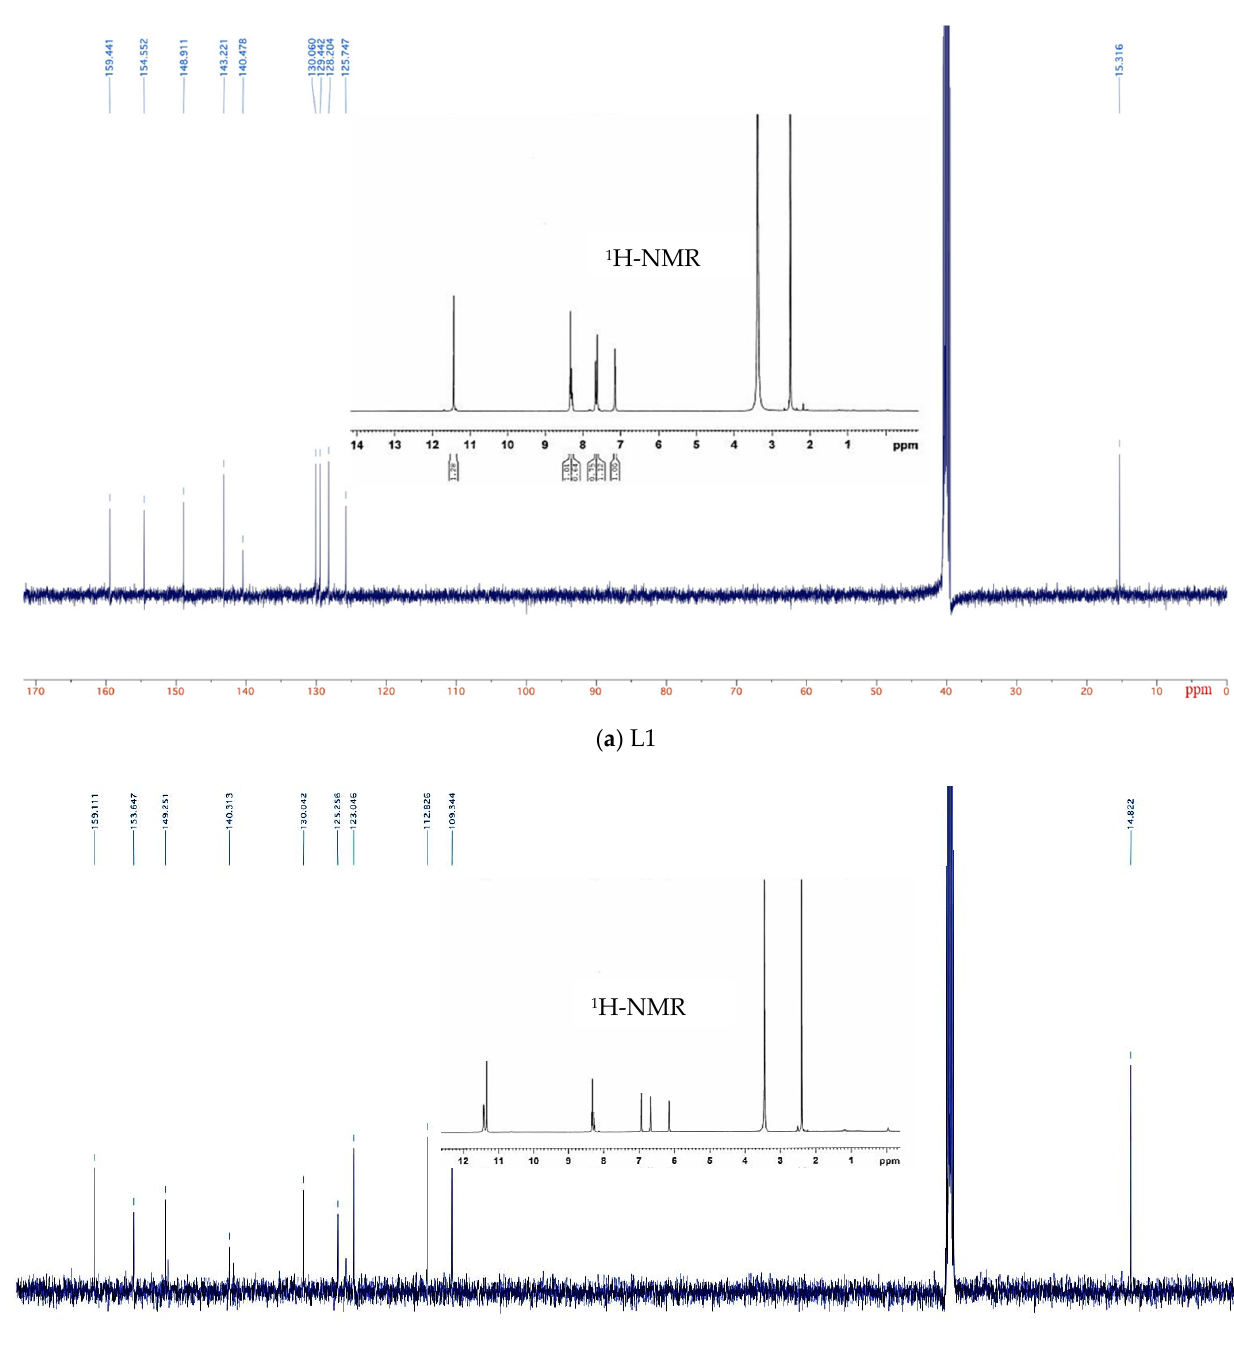
Figure 2. Experimental 1 H and 13 C-NMR of ( a ) L1 and ( b ) L2 in DMSO-d 6 solvent.